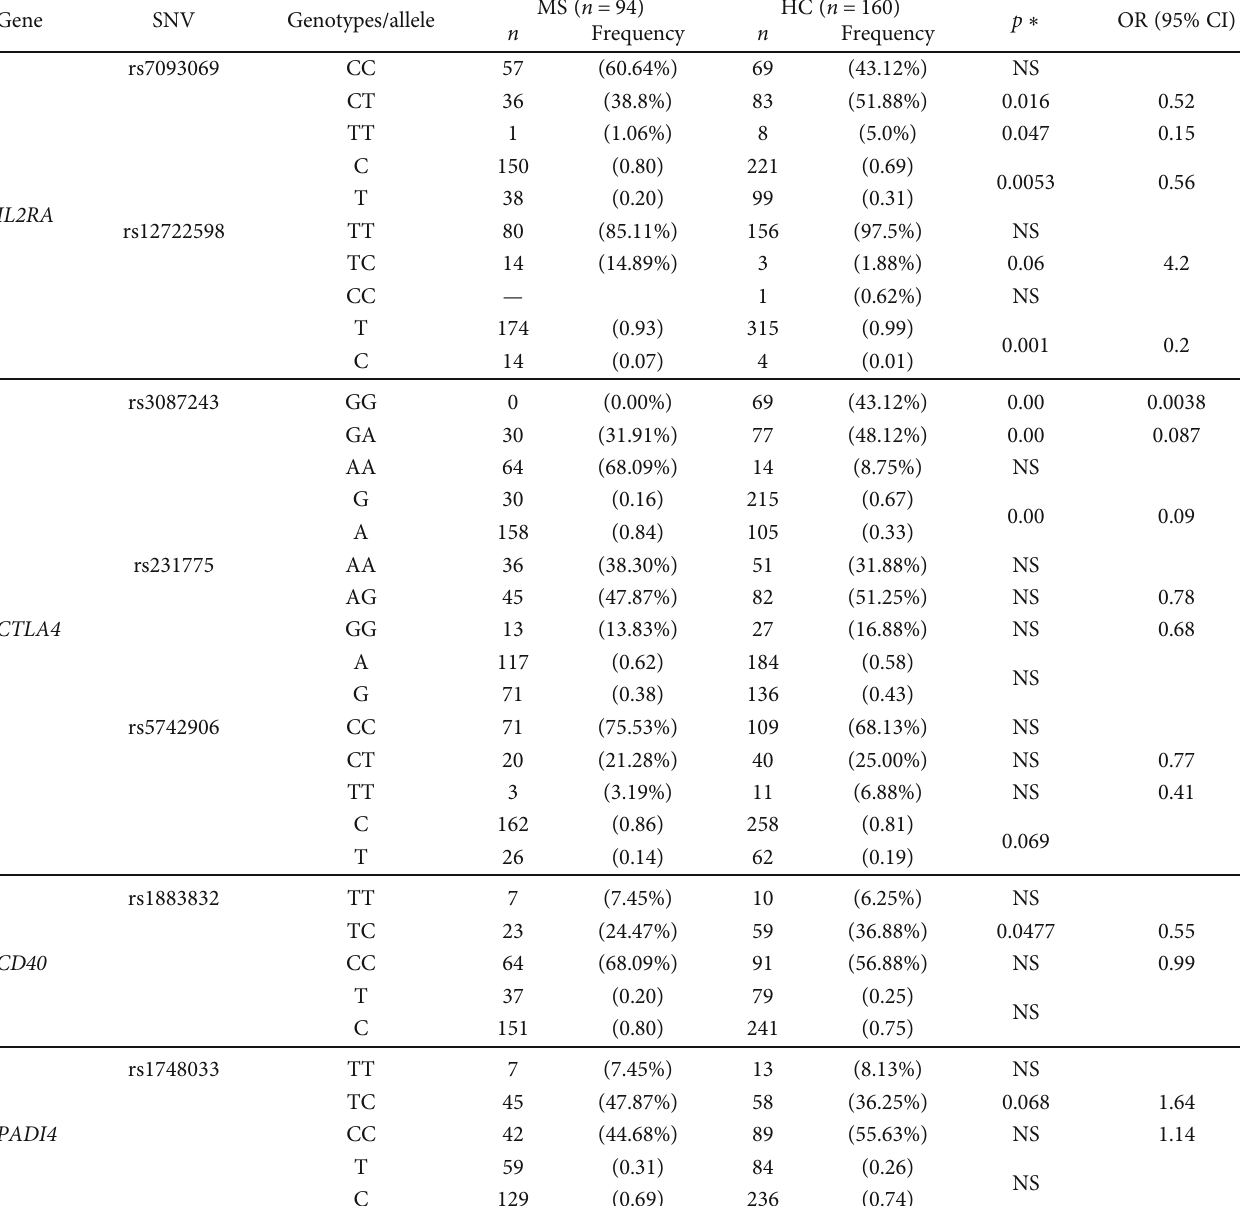
Table 2: The genotypes and allele frequencies in the studied